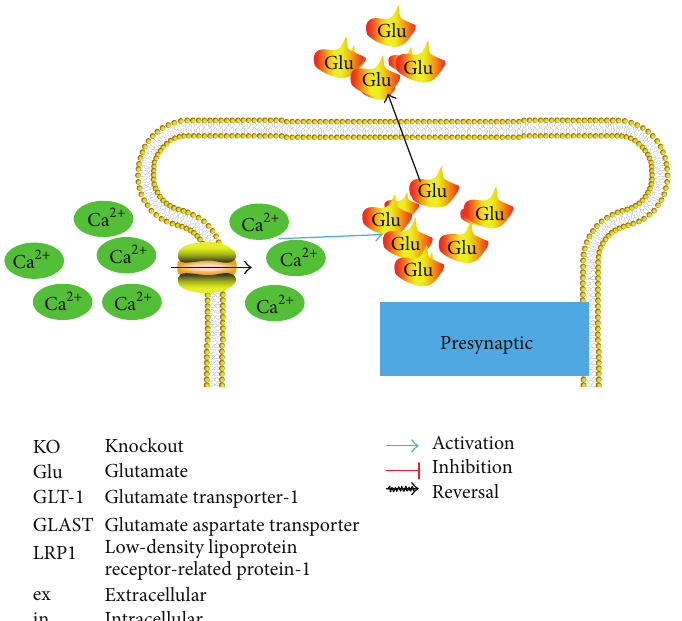
Figure 1: Neuroprotective effect of the association of AQP4/GLT-1 against glutamate-induced neuronal injury by A 𝛽 . (1) A 𝛽 targets. A 𝛽 may increase the release of physiological synaptic glutamate. This in turn results in neuronal NMDAR activation, which leads to synaptic damage and neurotoxicity. Glutamate uptake by astrocytes is also reduced after A 𝛽 infusion, which results in high extracellular glutamate concentrations, and, consequently, excitotoxicity. Glutamate dyshomeostasis could play a role in the pathogenesis of AD, and in this process, GLT-1 has demonstrated to undergo oxidative damage by exposure to A 𝛽 . (2) Glutamatergic system. GLT-1 is the major glutamate transporter that is responsible for various essential neuroprotective functions that include the prevention of glutamate-mediated injury of neurons and synapses; it accomplishes this through the transport of glutamate in the inward direction under normal conditions. In excitotoxic conditions, when the extracellular [Na + ]/intracellular [K + ] ratio is decreased and/or when the intracellular [Na + ]/extracellular [K + ] ratio is increased, glutamate is transported in the outward direction, such that GLT-1 reversal might further intensify glutamate-induced synaptic damage. (3) Consequences of AQP4 knockout. It is known that AQP4 deficiency may downregulate both GLT-1 expression and glutamate uptake, but it may also downregulate LRP1, which is involved in A 𝛽 clearance. Moreover, AQP4 deficiency could cause the inhibition of oxygen delivery from brain microvessels to the Na + /K + -ATPase. This might represent another important factor in the regulation of Na + /K + -ATPase function and ultimately the neuroprotection of GLT-1 against AD toxicity. (4) Neuroprotective effects of the association of AQP4 and GLT- 1. As a functional complex, AQP4 and GLT-1 in astrocyte cell membranes could exert neuroprotective effects, and the mislocalization and internalizationofGLT-1inastrocytemembranes,aspromotedbyA 𝛽 ,mightberesponsibleforthedisruptionofthismacromolecularcomplex. This leads to a marked reduction in the rate at which astrocytes clear glutamate from the extracellular space, and, most importantly, to the development of